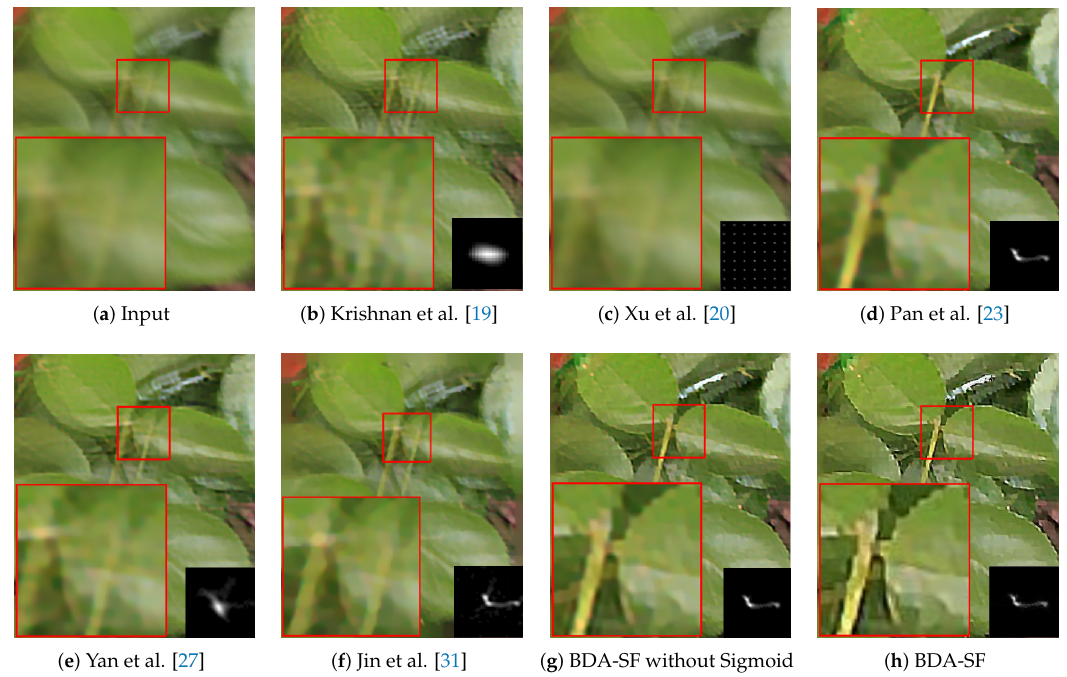
Figure 15. Visual comparison on a real natural image. BDA-SF achieves finer edges and details, as is shown in red boxes. (Best viewed on high-resolution display with